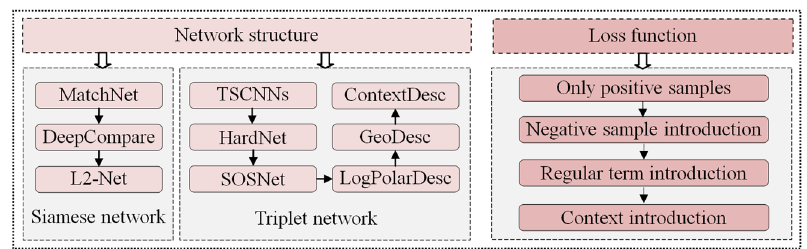
Figure 3. Development of deep-learning feature description.